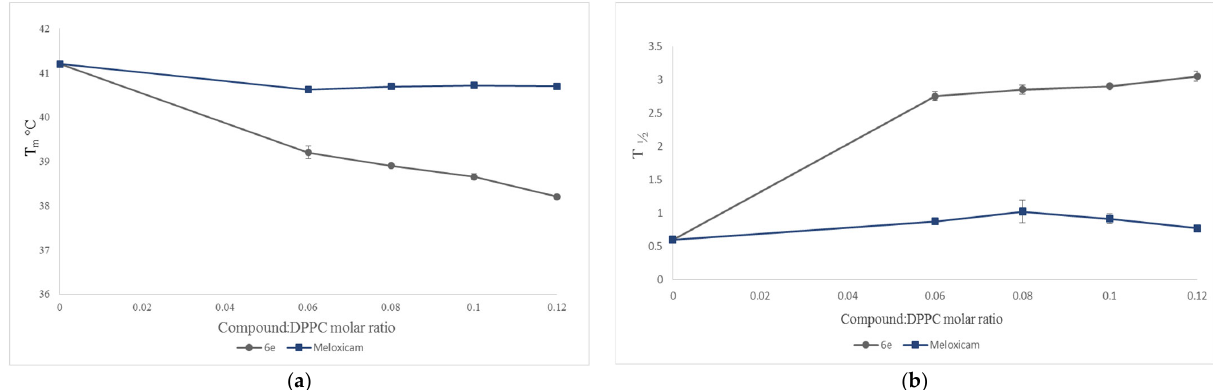
Figure 6. The influence of 6 e compound and Meloxicam on the DPPC: ( a ) main phase transition temperature (T m ); ( b ) peak half ‐ height width (T ½ ). Bars represent standard deviations of four measurements; where no error bars are shown, they were smaller than the symbols representing results.